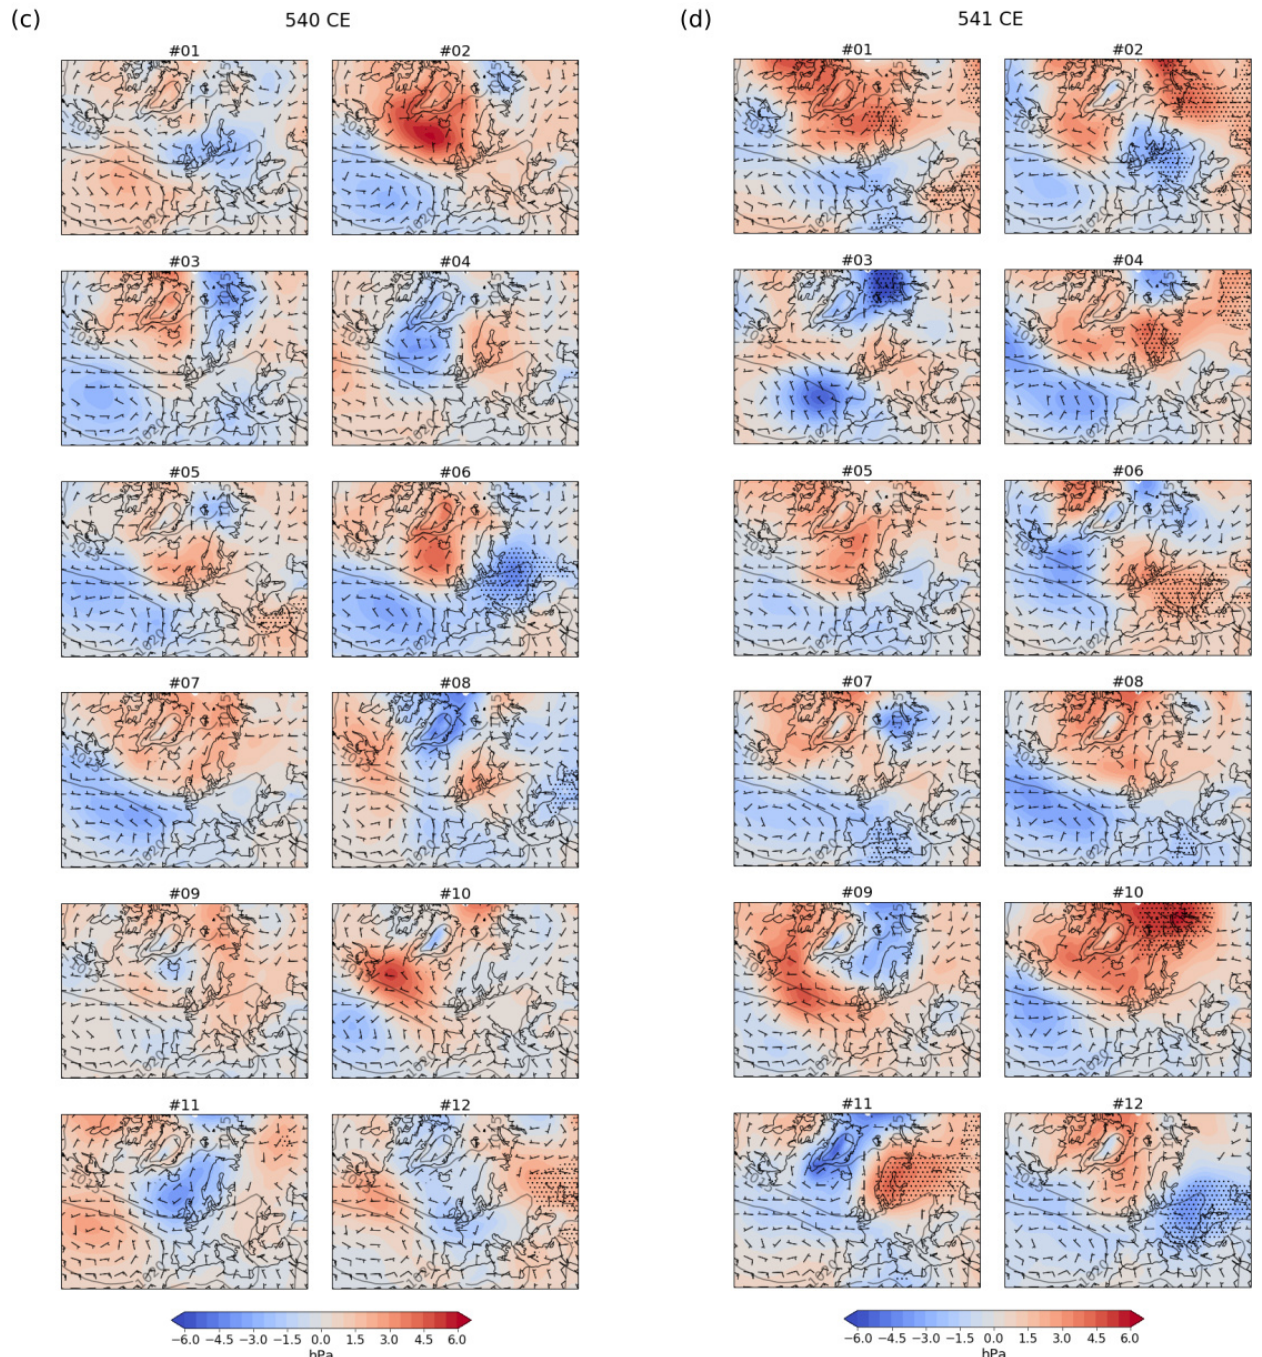
Figure A3. The same as Fig. A1 but for sea level pressure (SLP) anomaly and absolute wind. SLP contours and wind barbs are shown for 5hPa and 1, 5, and 10ms − 1 intervals,